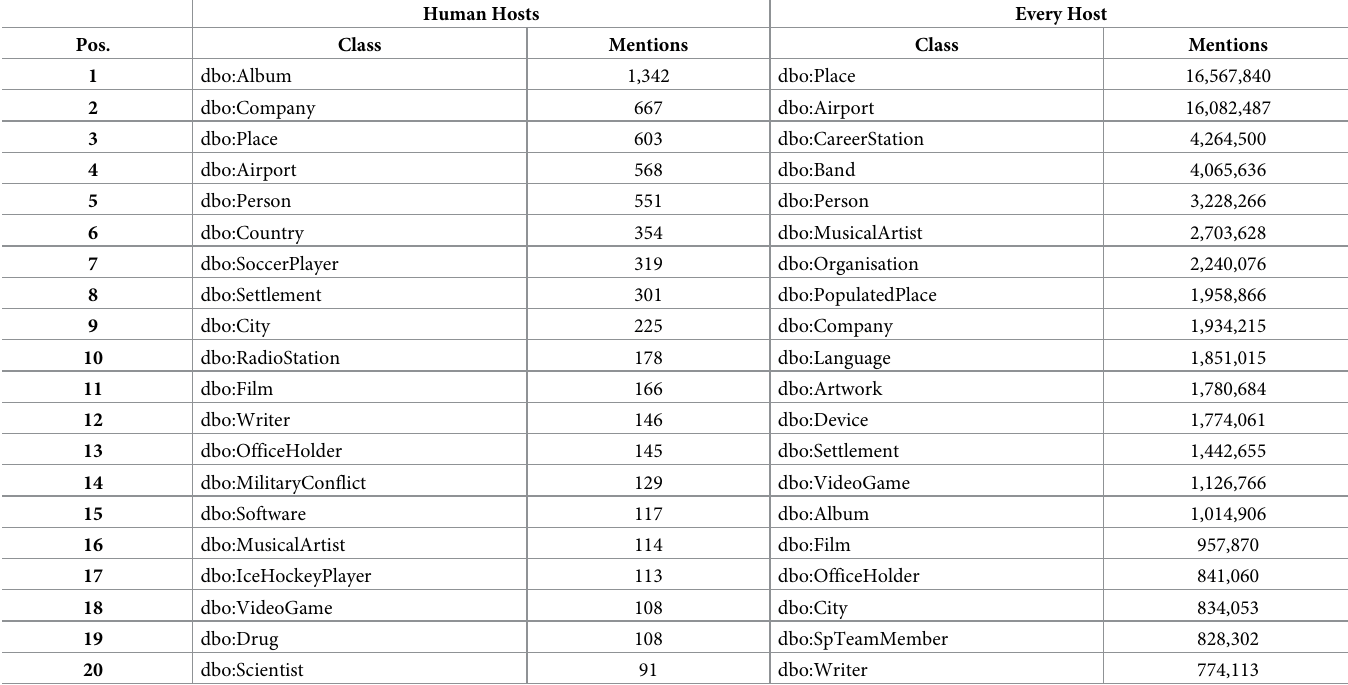
Table 2. Top20 elements for HH and EH entries in